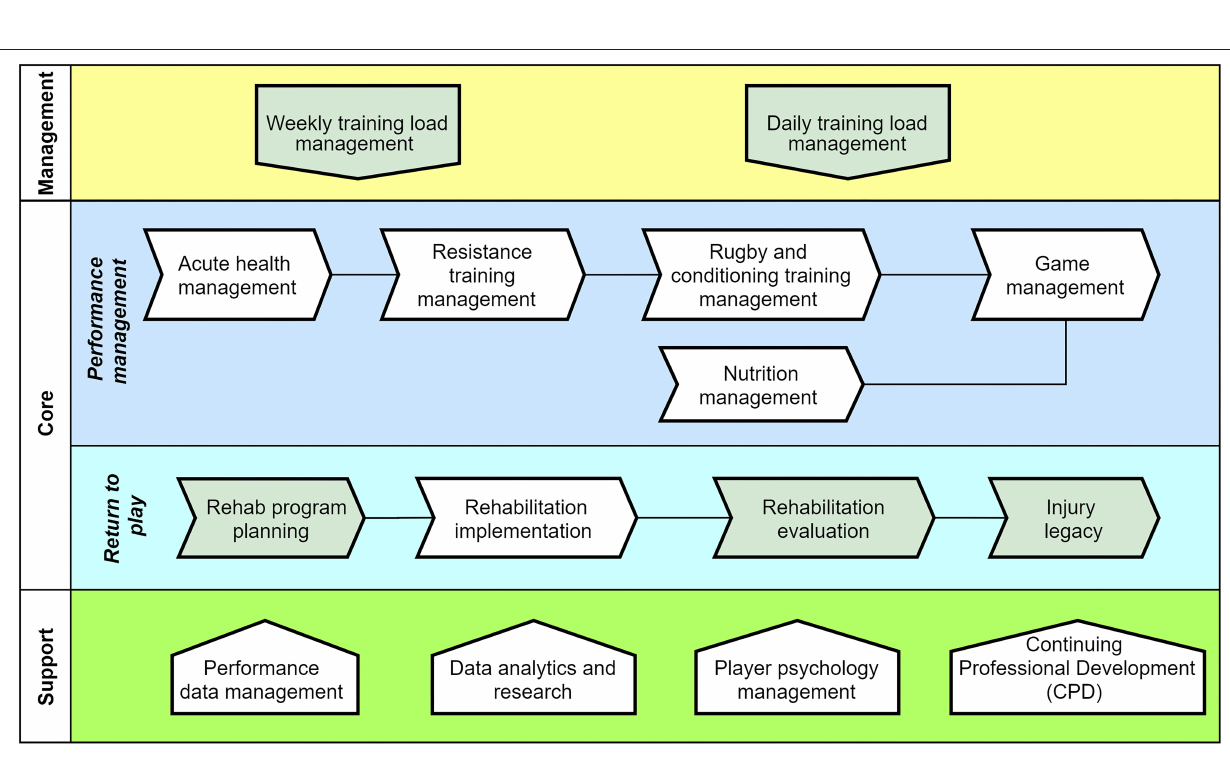
Frontiers in Sports and Active Living |